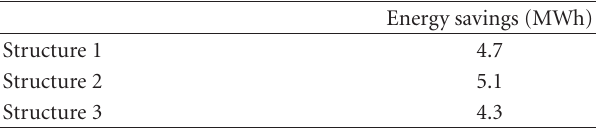
Table 5: Energy savings (MWh) in the threshold zone for the three tension